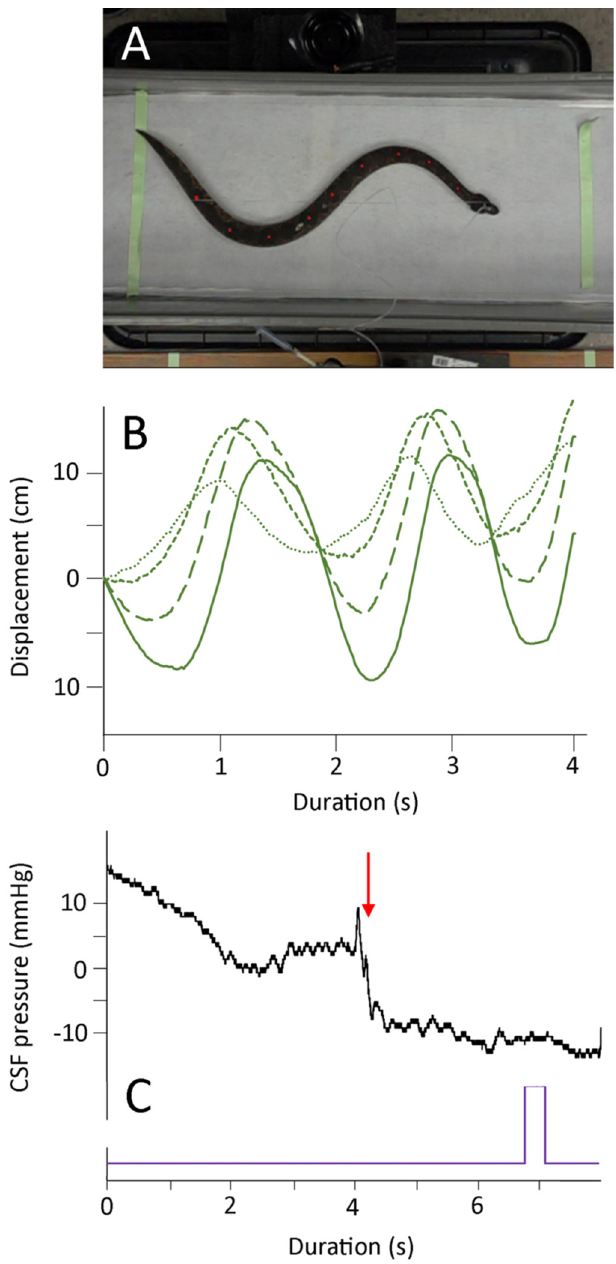
Figure 5. Summary of the undulatory locomotion. ( A ) Isolated frame from the high-speed digital video; note that the snake’s body is not elevated and the marker points on the snake’s dorsal surface are clearly evident. ( B ) Kinematic data showing the lateral displacement of four successive body marker points (successive points have finer line dashes); note that these oscillations occur at a lower frequency than those recorded during manual oscillations (Figure 3B). ( C ) Cranial CSF pressure recorded during an undulatory locomotion trial. The onset of locomotion is marked by a red arrow; the purple marker is an integration signal that appeared in all kinematic and pressure records, allowing for the temporal alignment of the data sets.